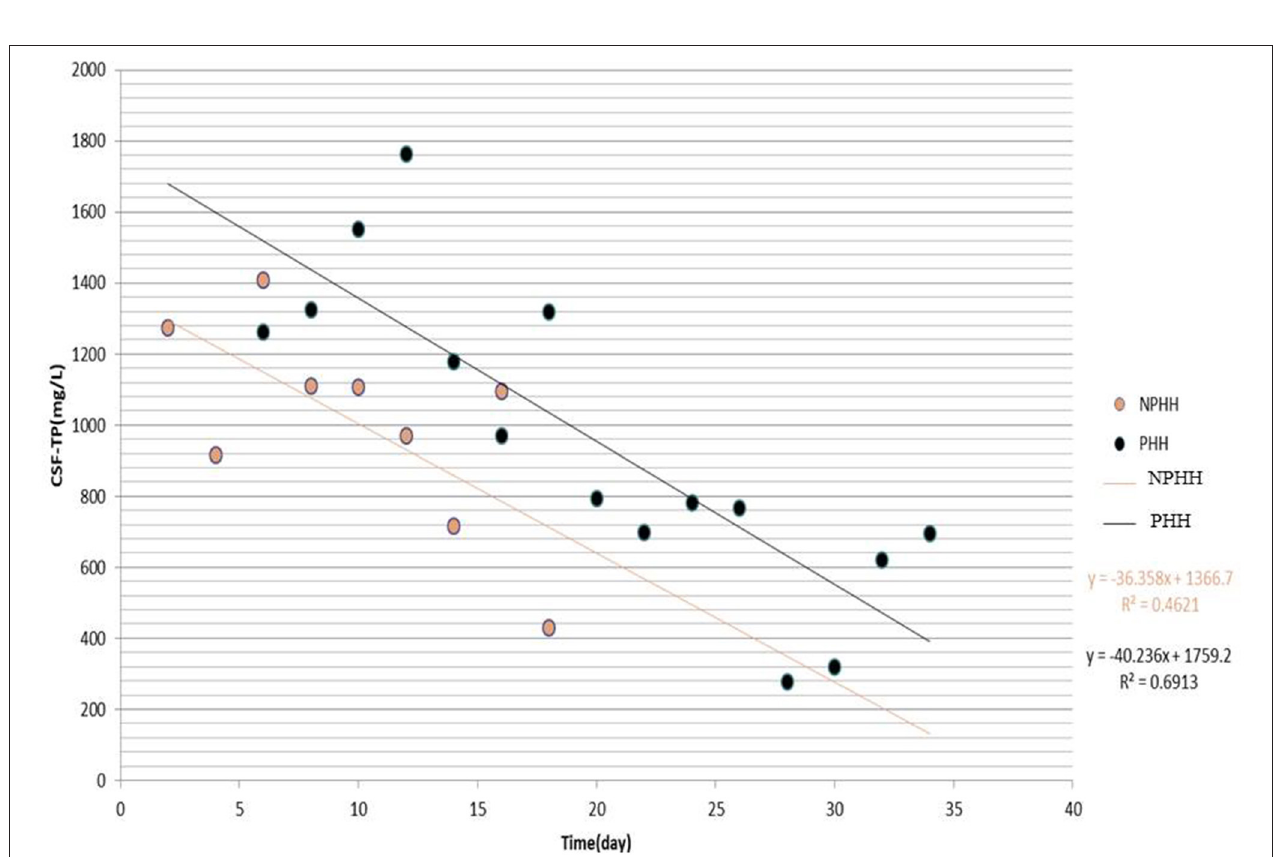
FIGURE 3 | Distribution of CSF-TP after grouping the Time by 2 days. X-axis:0 means the beginning of the disease.